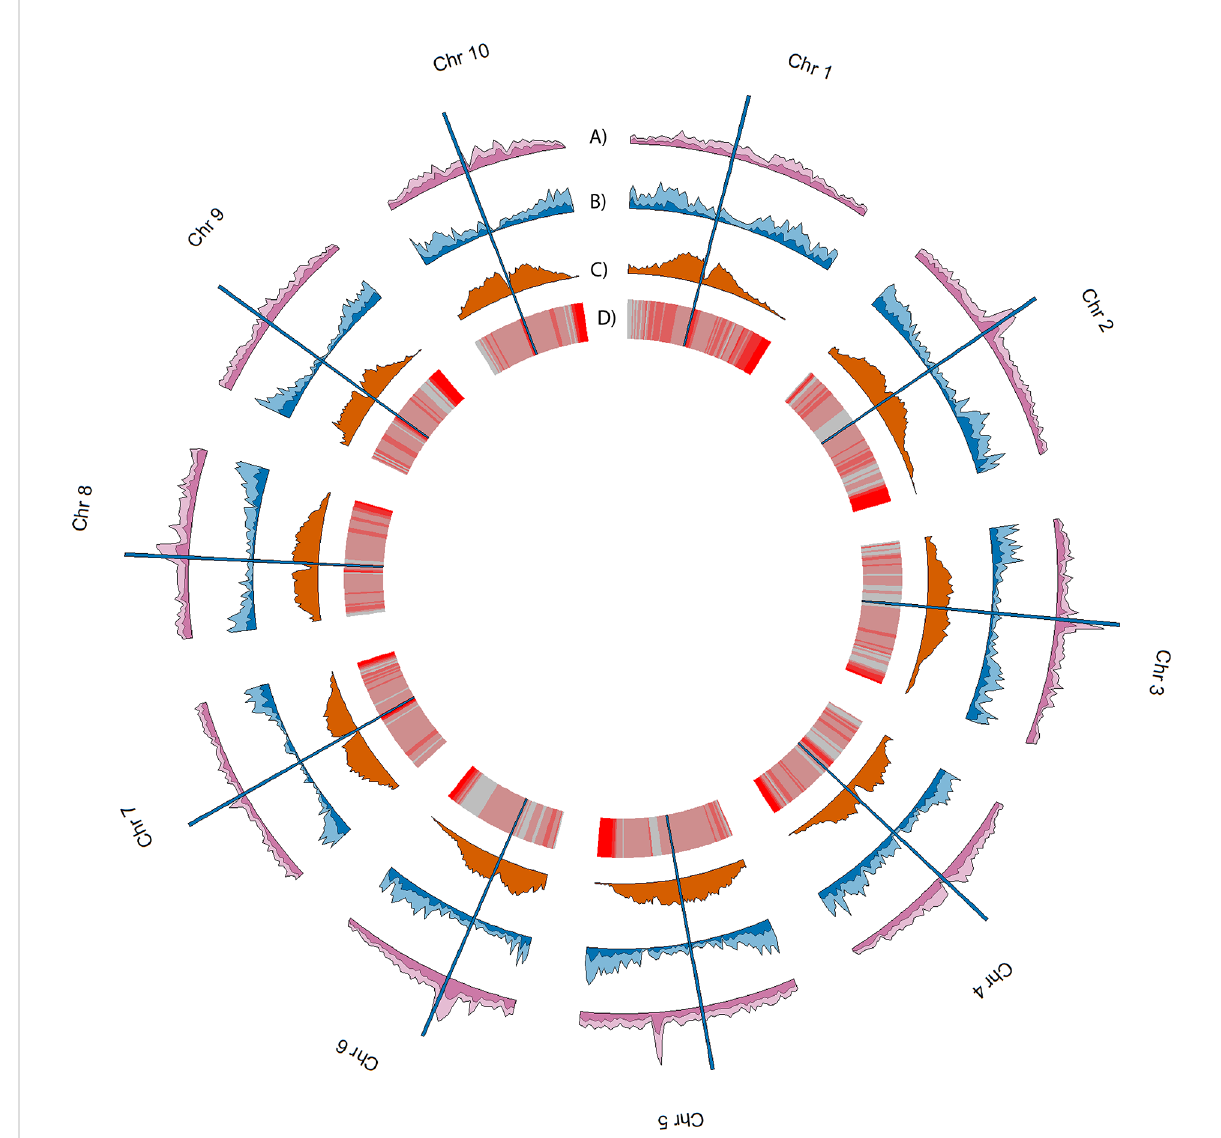
FIGURE 3 Genomic landscape of variation averaged across the 10 genomes. Density estimates in tracks A-C were performed in 1Mb non-overlapping sliding windows. (A) and (B) respectively show average SNP density and average SV density, with lighter colors indicating cloud variants and darker colors indicating shell and core variants. (C) shows the average TE density, and (D) shows TE age averaged across 1Mb sliding windows. Red indicates younger TEs while gray indicates older. Vertical blue bars spanning all tracks indicate the approximate position of the centromeres of each chromosome.